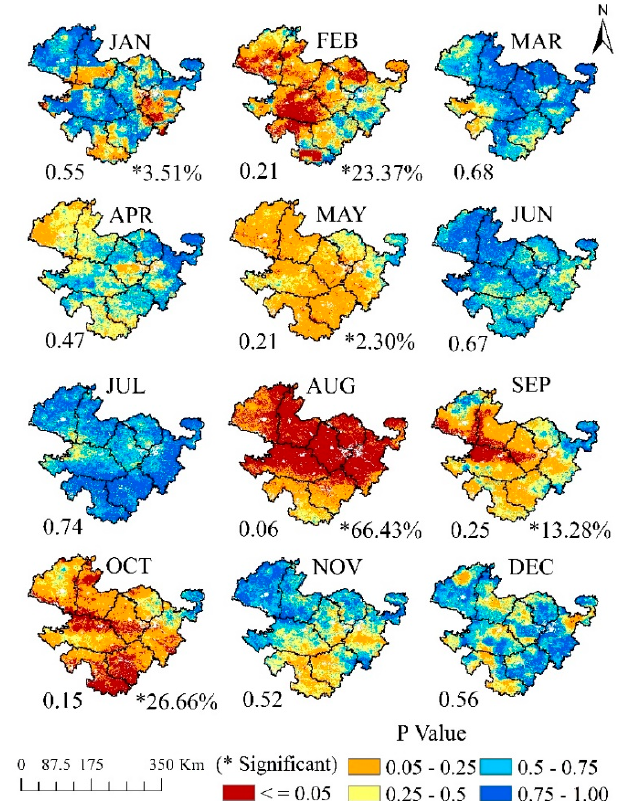
Figure 10. Monthly trends (statistical p-value) in PCA-based CDI_M (bottom right value represents the percentage-wise area with a significant change in the CDI_M, and bottom left numbers indicate the average p-value) .